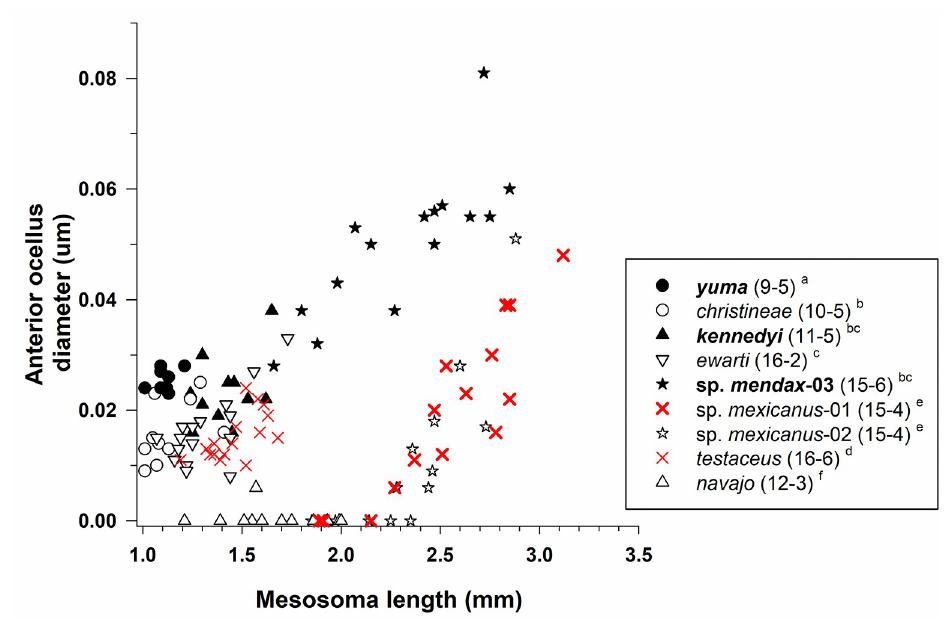
Fig 6. Anterior ocellus diameter for species of Myrmecocystus (subfamily Formicinae: Tribe Lasiini). Six species are pale (open or red symbols and normal font: M . christineae , M . ewarti , M . navajo , M . testaceus , M . mexicanus -01, M . mexicanus -02), and three species are dark (filled symbols and bold font: M . yuma , M . kennedyi , M . mendax -03 ) (see text). For each species, number of workers examined and number of colonies they were derived from is given in parentheses. Significant differences ( P < 0.05) among species are denoted after each species name by the letters a–f : a > b > c > d > e > f ; the three sets of letters for each species correspond to panels A, B, and C, respectively. Groupings are based on univariate F tests within ANCOVA followed by pairwise comparisons of the estimated marginal means using a least significant differences test (see text).